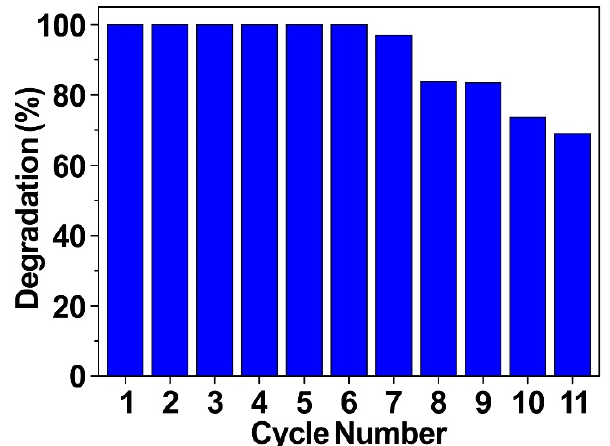
Figure 7. Degradation of methylene blue using the 10X PVP AgCl@AgAu NPs as photocatalysts used repeatedly for 11 times.